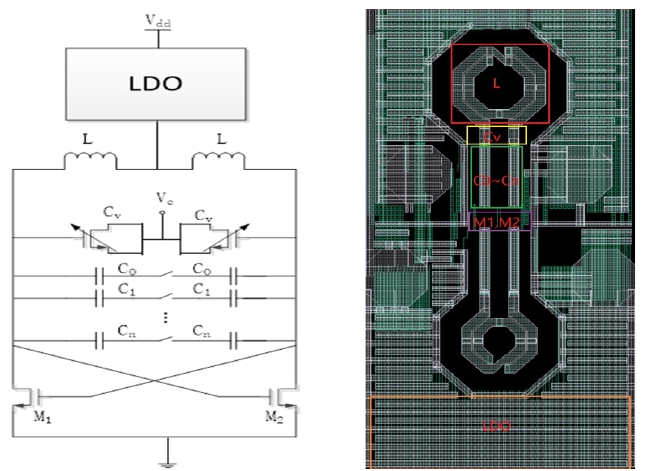
Figure 2. LC voltage-controlled oscillator (VCO) structure and passive inductance layout. LDO: low dropout regulator.